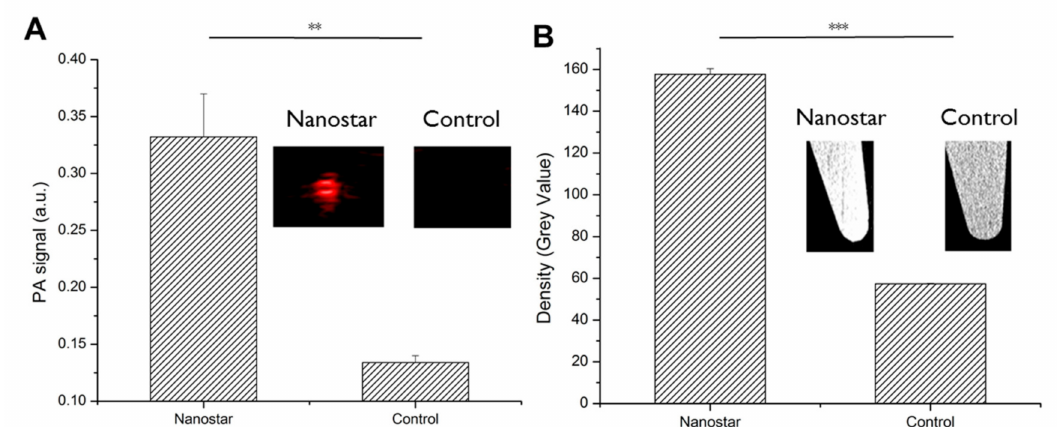
Figure 2. ( A ) Photoacoustic images of nanostars and water in tubes, which were quantified by plotting the signal amplitudes. ( B ) Computed tomography (CT) images of microcentrifuge tubes either filled with water or nanostars suspension. The corresponding signal amplitudes were used for quantification. (Error bars represent SD of triplicate samples; * p < 0.05, ** p < 0.01, *** p <